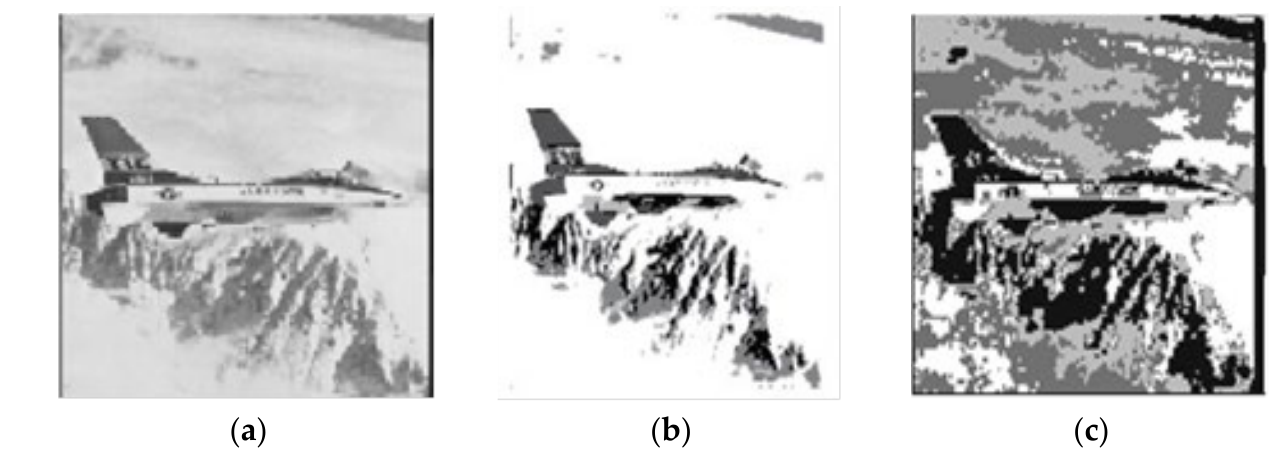
Figure 5. Airplane segmented image: ( a ) original image, ( b ) PIABC-FCM, and ( c ) IABC-FCM.